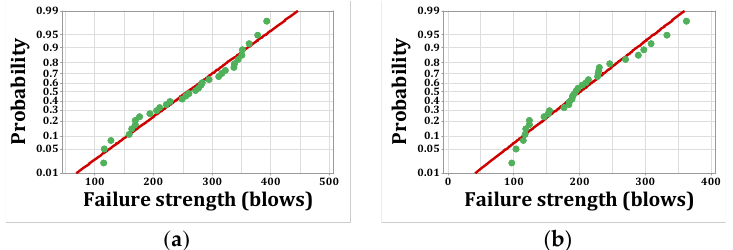
Figure 23. Normal probability plots for failure strength (humid): ( a ) F5, ( b ) F2F3.